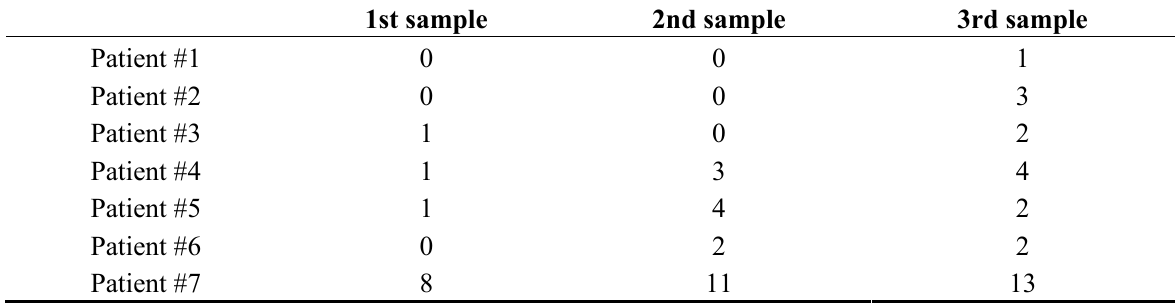
Table 1. CTC number per 1 mL of blood obtained from seven melanoma